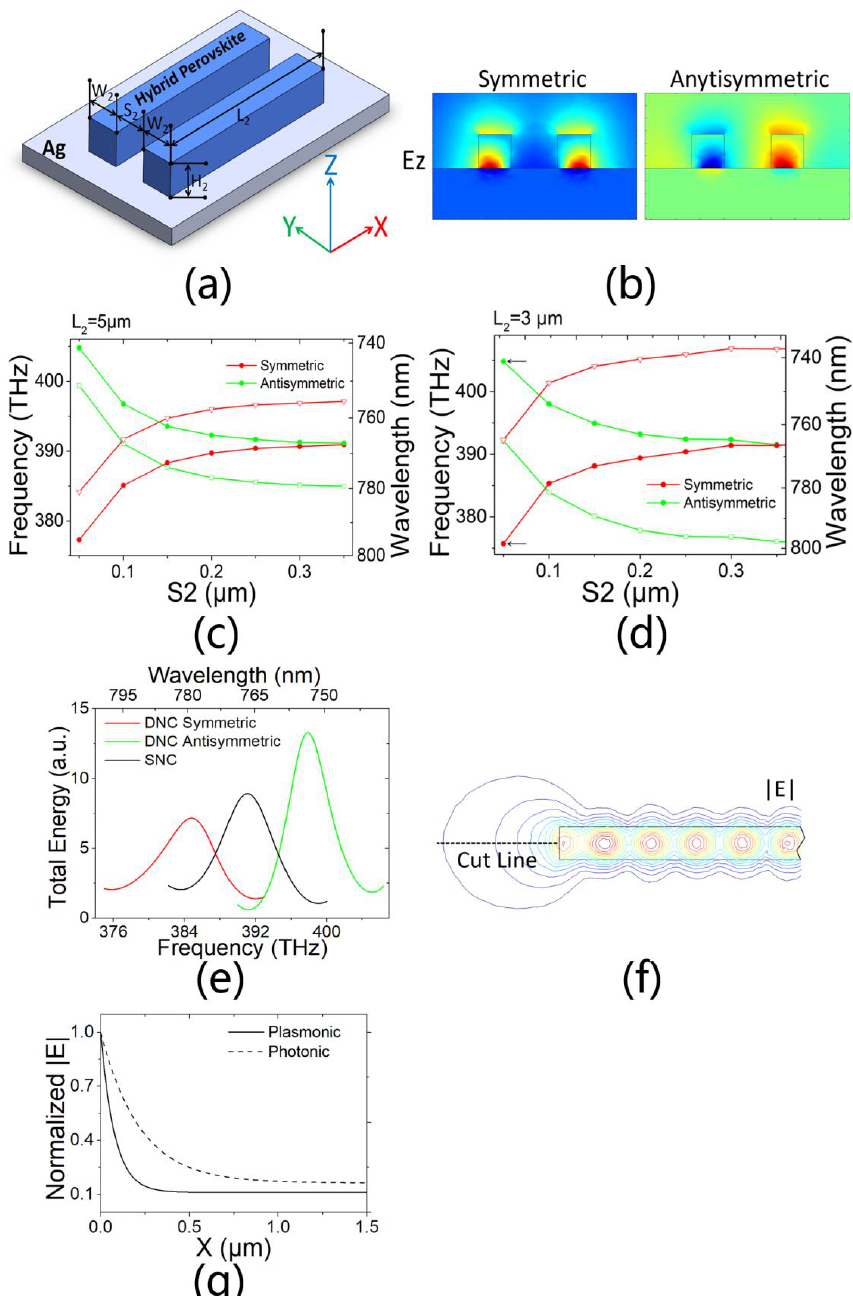
Figure 3. ( a ) Coupled plasmonic DNC. S 2 = 0.2 mm. L 2 = 3 µ m; W 2 = H 2 = 0.135 mm. The refractive index of hybrid perovskite semiconductor nanowire n = 2.59–0.015 i. The Ag substrate has parameters of ε ∞ = 3.75, ω p = 1.32 × 10 16 rad/s, γ = 1.20 × 10 14 rad/s. ( b ) E field distribution at y–z cross section of symmetric and antisymmetric modes. The z component of the E field is shown here. ( c ) Resonant frequencies of symmetric and antisymmetric modes versus S 2 when L 2 = 5 µ m. ( d ) Resonant frequencies of symmetric and antisymmetric modes versus S 2 when L 2 = 3 µ m. ( e ) Total energy spectra for mode of plasmonic SNC and corresponding two supermodes of plasmonic DNC with S 2 = 0.1 µ m when L 2 = 3 µ m. ( f ) Contour plot of the electric field norm for a longitudinal mode of plasmonic SNC. ( g ) Normalized electric field amplitudes versus distance from the ends of nanowires along the cut line (shown in ( f ) and Figure 2b) selected by main radiation directions for the mode of plasmonic SNC (line) and the mode of photonic SNC